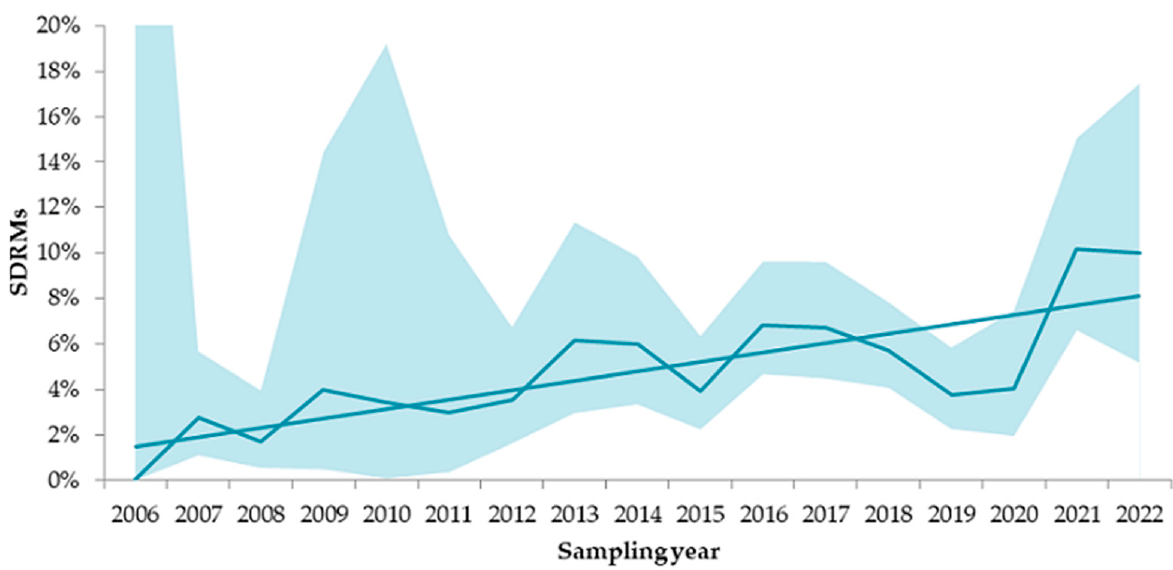
Figure 2. Temporal trends in SDRMs in Russia in the 2006–2022 sampling years. The range of the 95% confidence interval is represented as a blue cloud around a line. Abbreviation: SDRMs, surveillance drug resistance mutations.